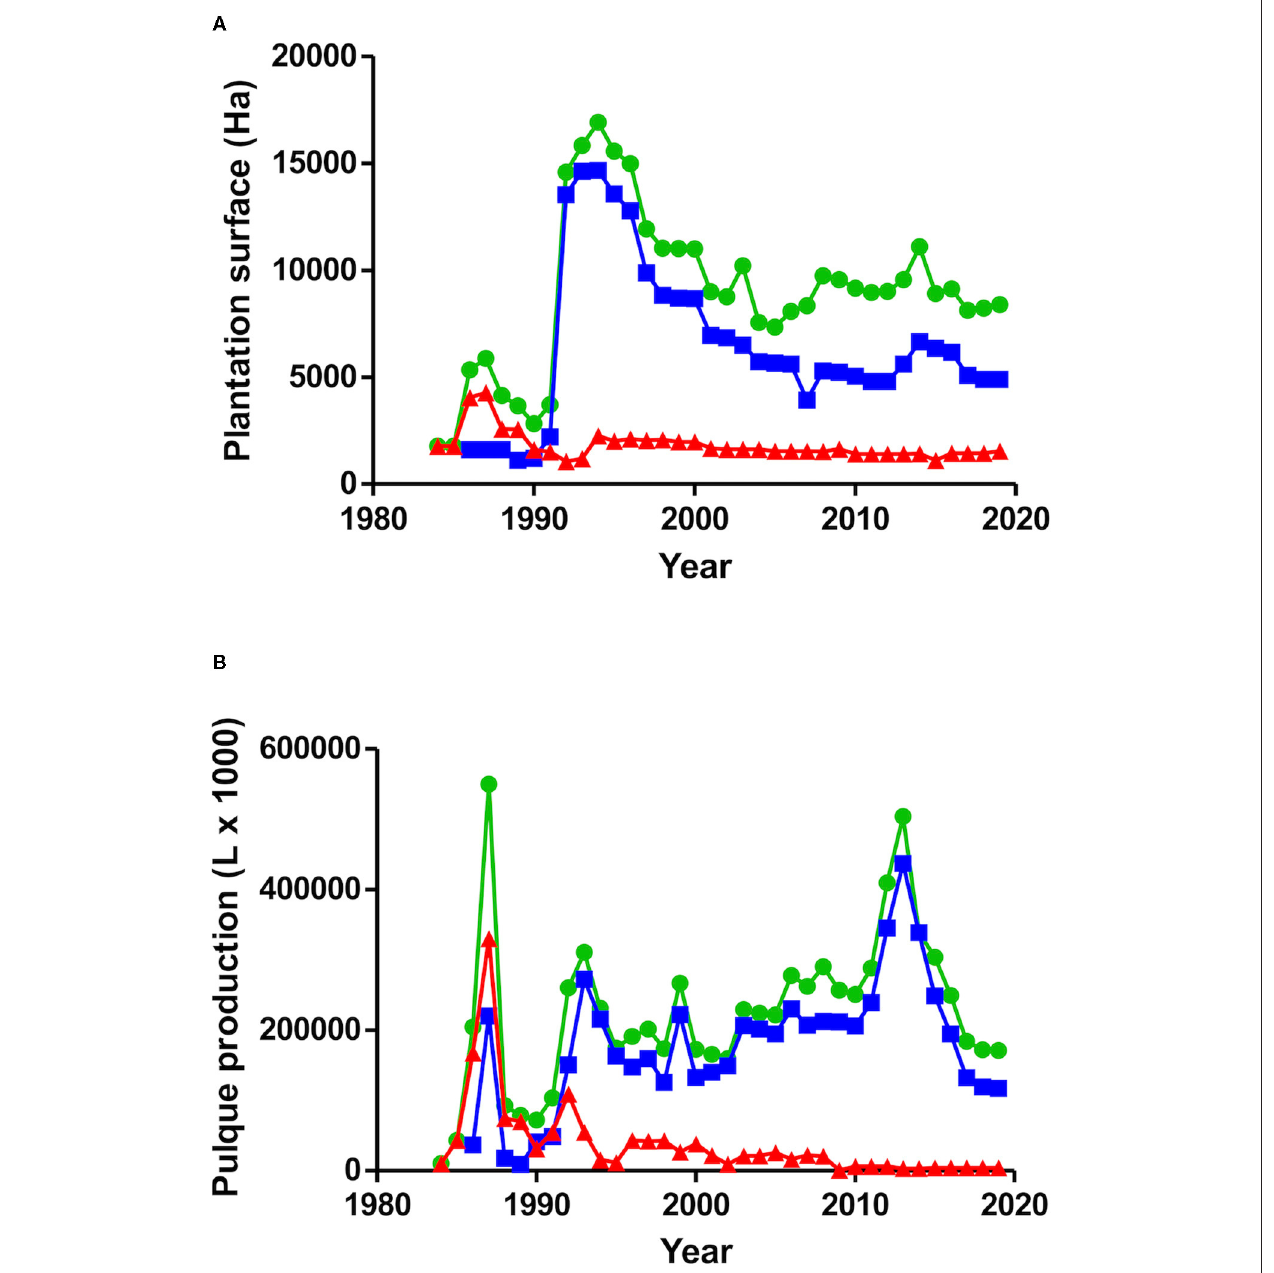
FIGURE 1 | Plantation surface of maguey pulquero plantation and pulque production. (A) Reported cultivated surface (ha) for maguey pulquero . (B) Reported pulque production associated to maguey plantations on basis of the available information at the Anuario Estadístico de la Producción Agrícola, Servicio de Información Agroalimentaria y Pesquera (2021). • National; (cid:4) Hidalgo; N Estado de